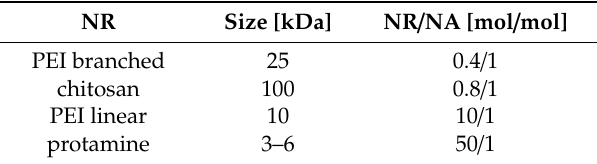
Table 2. Neutralization of mRNA with neutralization reagents (NR). The analyzed NRs, their sizes, and the most e ffi cient molar ratios of NR / mRNA (NA) are given.